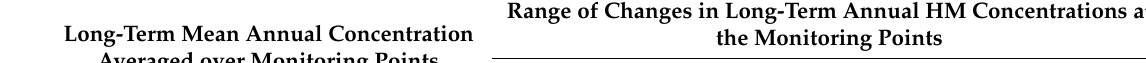
Table 2. Observed and simulated HM concentrations and its ranges of changes in monitoring points ( µ g · L − 1 ).